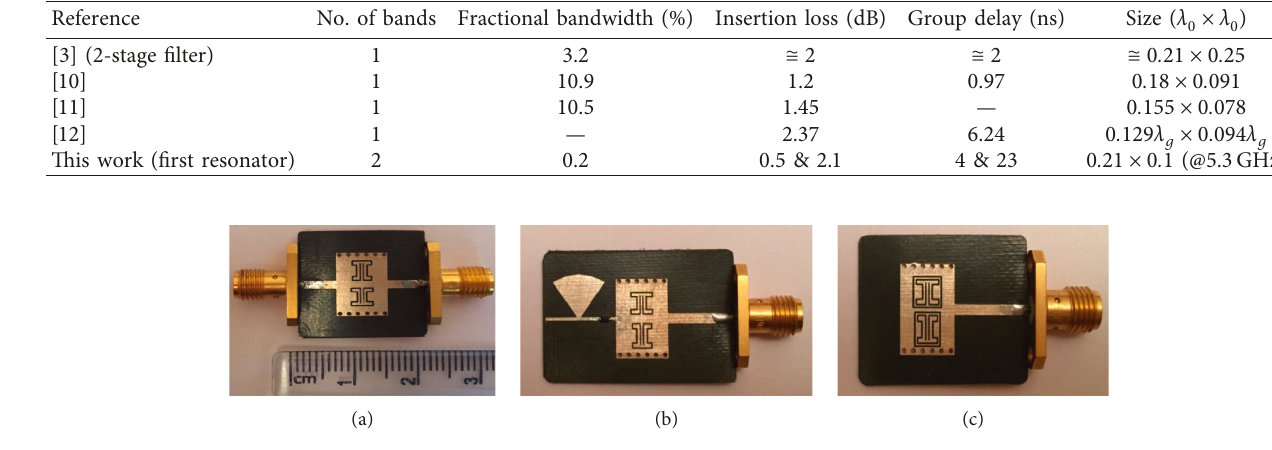
Figure 9: Images of the fabricated resonators.